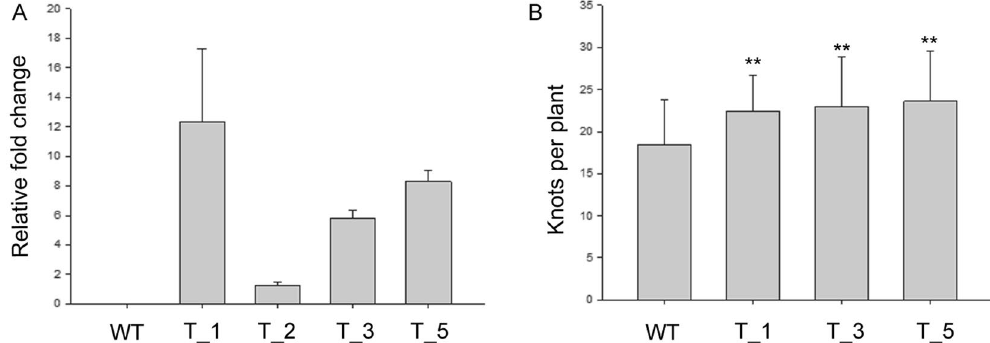
Figure 6. MiISE5 overexpression in Arabidopsis promotes nematode susceptibility. ( A ) q-PCR assays were used to determine the expression of MiISE5 in four independent transgenic lines. ( B ) The average number of galls per root. Each bar represents the mean ± SD of three biological replicates, and the mean values significantly different from the control are demoted by ** as determined by independent samples t -test (P < 0.01).